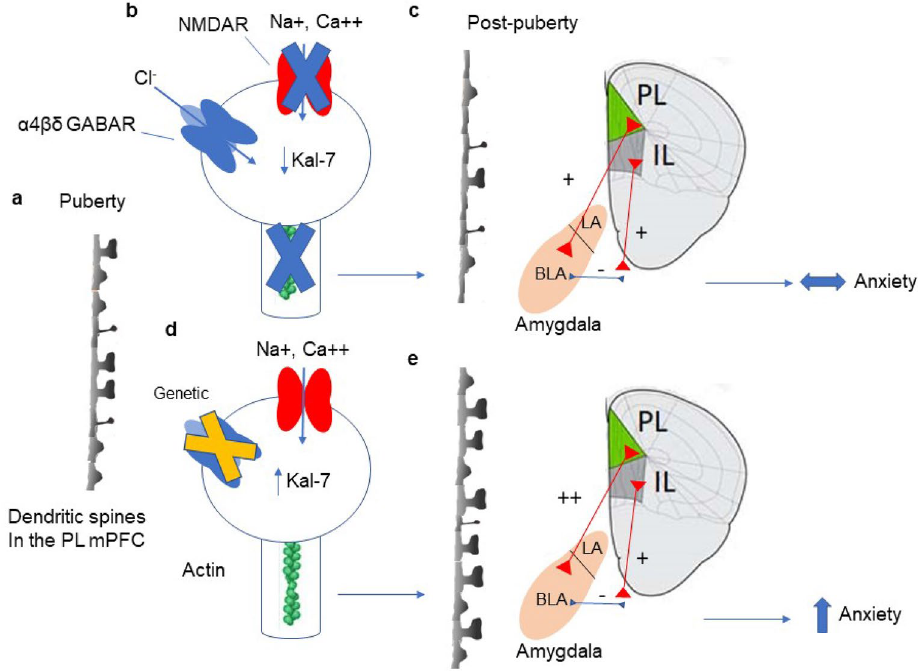
Figure 7. Summary figure. ( a ) Schematic diagram showing representative dendritic spines in L5 PL at puberty. ( b ) Normally, expression of α4βδ GABARs increases on the spine at puberty where they gate a Cl − current that is inhibitory and impairs activation of NMDARs, which gate Na + and Ca ++ conductances. This decreases Kal-7 expression, resulting in actin de-stabilization, which causes synaptic pruning of L5 PL pyramidal cells. ( c ) The decrease in spine density represents a loss of synaptic input to L5 PL post-pubertally, which reduces excitatory output to the basolateral amygdala. Because this is offset by inhibitory input from the IL, anxiety behavior is unchanged in late adolescence. ( d ) When α4βδ GABAR expression is reduced at puberty (genetically or pharmacologically), NMDARs can generate Kal-7 expression, which stabilizes the actin cytoskeleton, preventing pruning. ( e ) This increased spine density of L5 PL would increase activation of the basolateral amygdala, thereby increasing anxiety in late adolescence. PL prelimbic mPFC, IL infralimbic mPFC, LA lateral amygdala, BLA basolateral